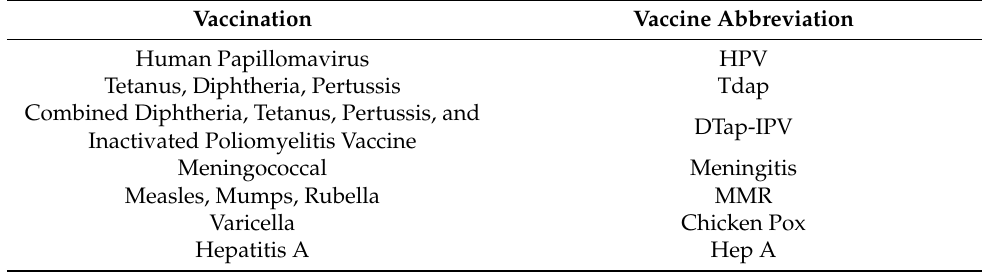
Table 1. Vaccinations and their abbreviations.